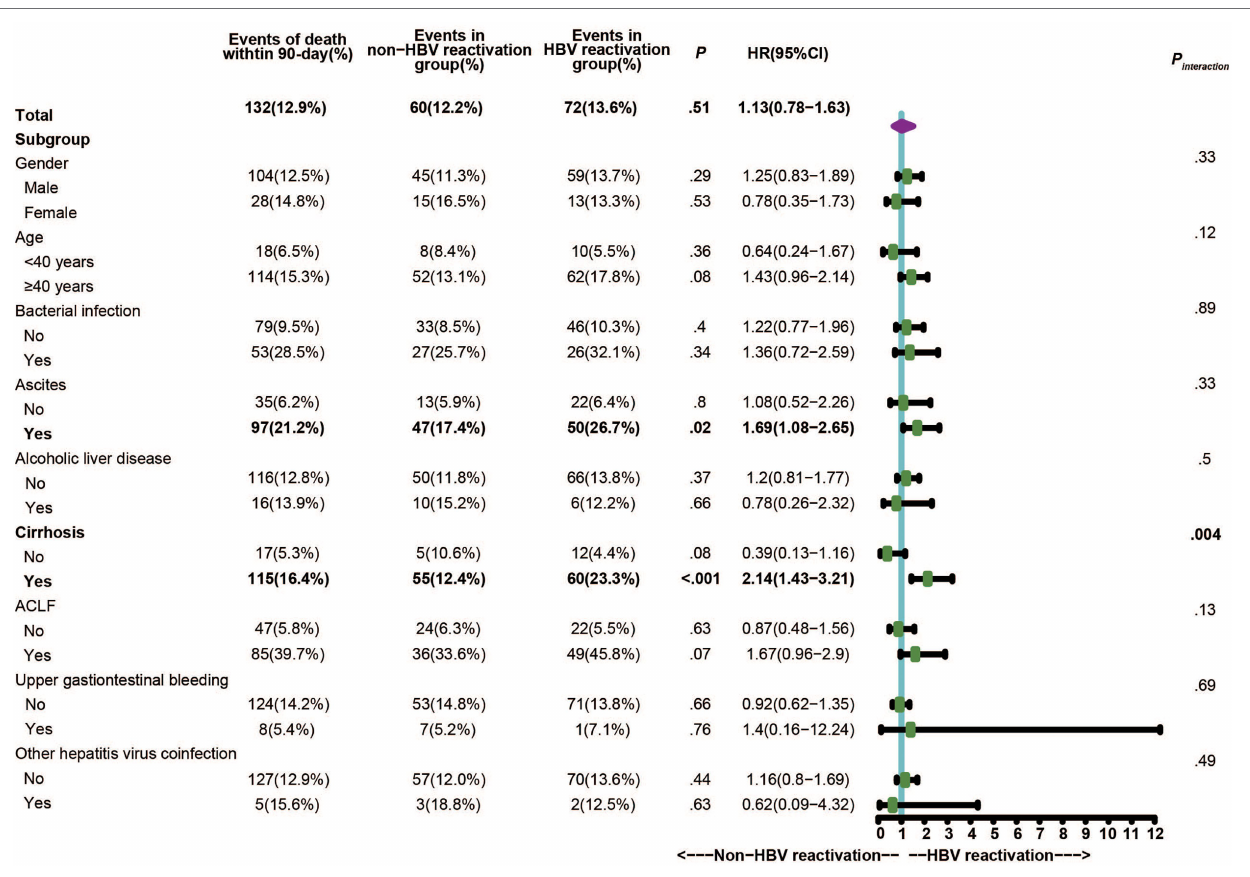
FIGURE 3 | Stratified and interaction analysis to identify the subgroup that interacted with HBV reactivation on the critical outcome of